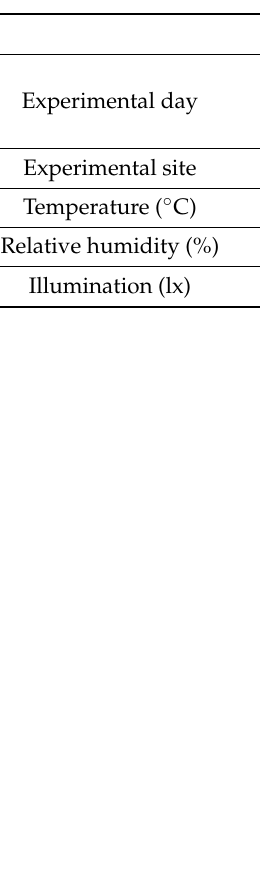
Figure 2. Experimental scene in the city area. The top left photo (spring), bottom left photo (fall), and bottom right photo (winter) are reprinted from Song et al. (2014) [20], Song et al. (2015) [21], and Song et al. (2013) [22], respectively. Table 1. Details of the experimental site.